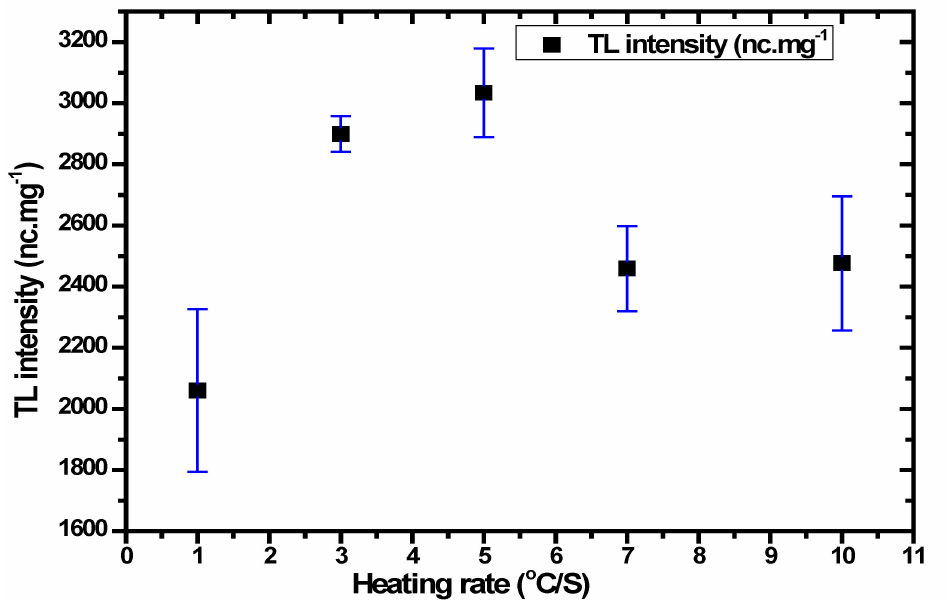
Figure 10. TL response of Ag-doped ZnO thin films as a function of heating